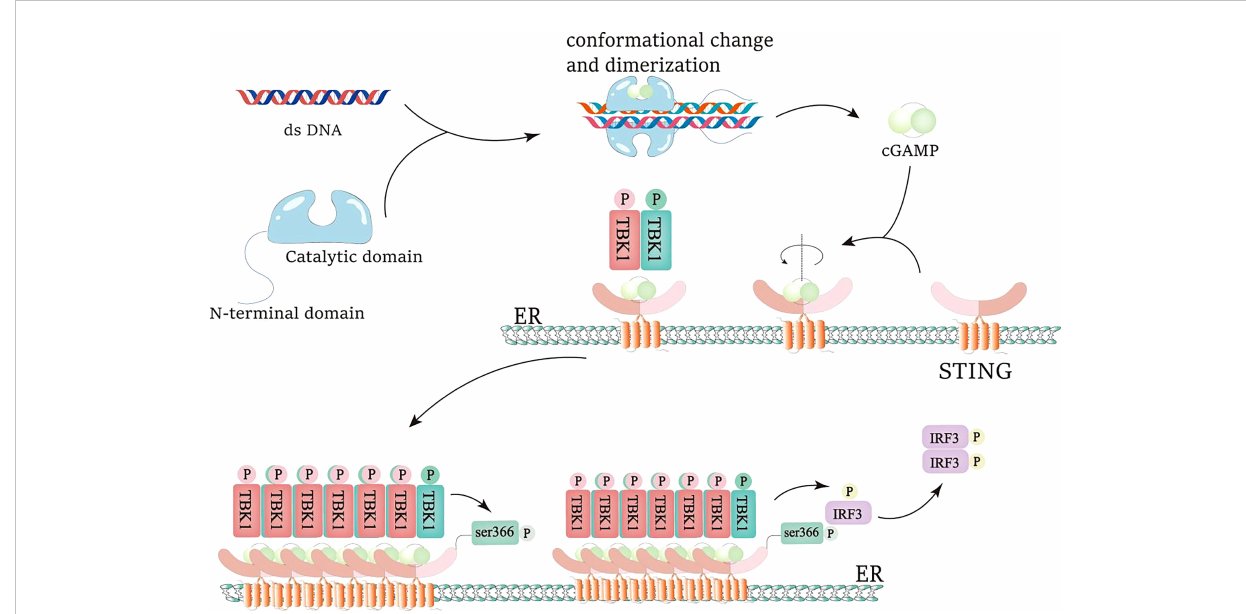
FIGURE 1 IRF3 activation of cGAS-STING pathway. dsDNA is recognized and combined by cGAS, resulting in the conformational change and dimerization of cGAS and the generation of cGAMP. When cGAMP is combined with the STING pocket structure, the STING dimer rotates 180°relative to the transmembrane helmets, which is bene fi cial to the oligomerization of the STING dimer and the promotion of the trans-phosphorylation of TBK1. Active TBK1 generates the docking site of IRF3 by phosphorylating the S366 site of STING. Then, active TBK1 phosphorylates IRF3, promotes IRF3 dimerization, and makes IRF3 obtain transcriptional